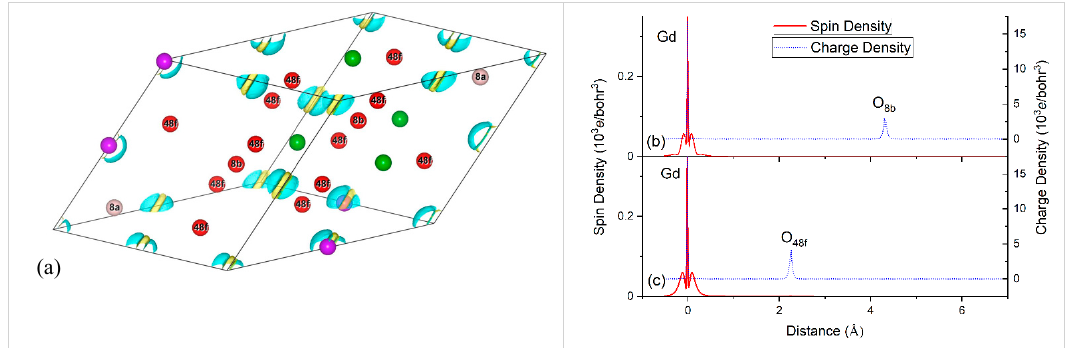
Figure 9. ( a ) OP-GHO antisite spin density isosurfaces. Isodensity surfaces of 0.0015 e / bohr 3 are displayed. Lines show the unit cell boundaries. Colors are atoms (Green = Hf; Purple = Gd; Red = O; Pink = O ghost atom). The O sites are shown. Yellow and cyan represent spin-up and -down cases, respectively. ( b , c ) represent the spin and charge density profiles. Charge density peaks denote nuclear positions.